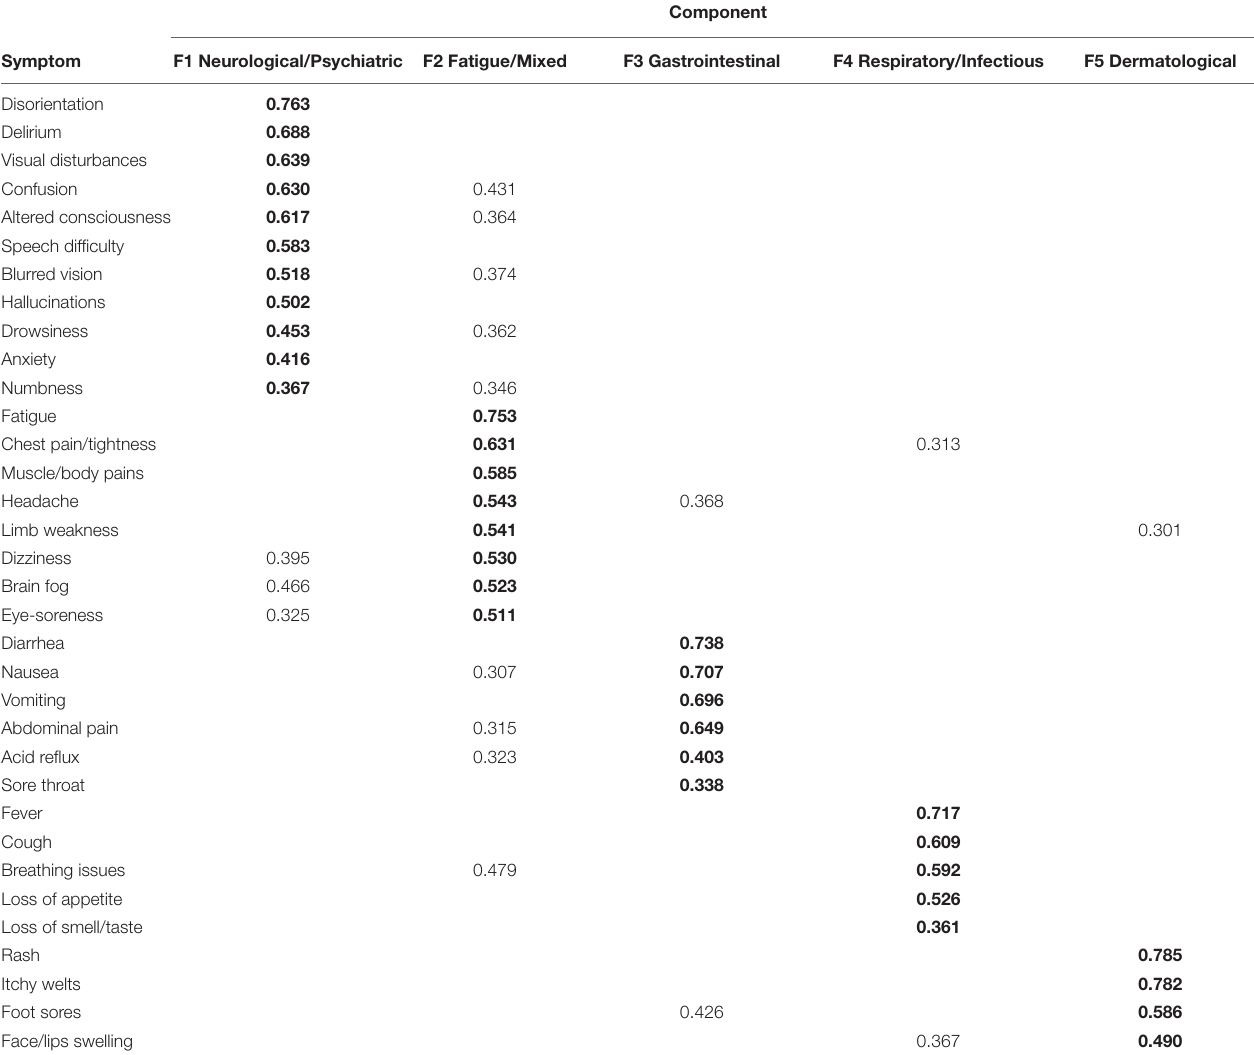
TABLE 3 | Factors and loadings from the “Initial Symptoms”